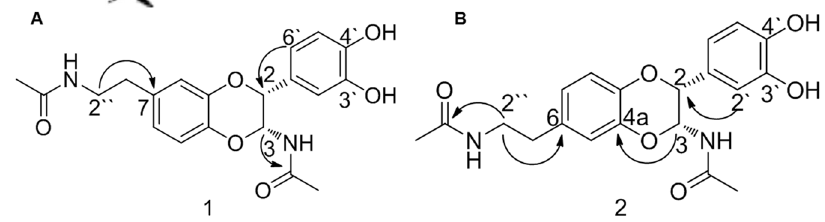
Figure 2. Key HMBC ( ) correlations of compounds 1 and 2.